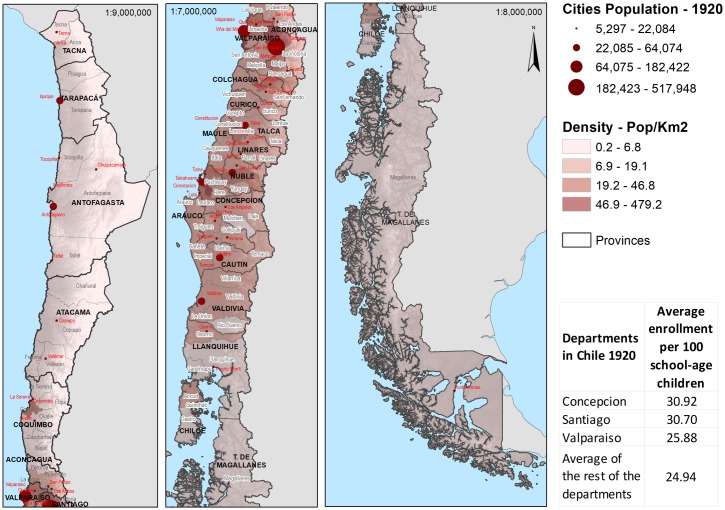
Map of Chile 1920.